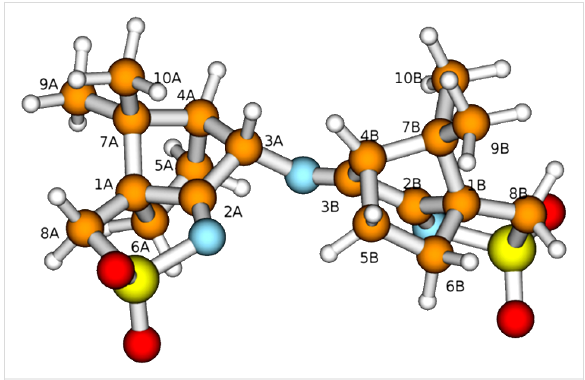
Figure 5: Optimized structure of 2 (( S )-3A isomer) with labeling